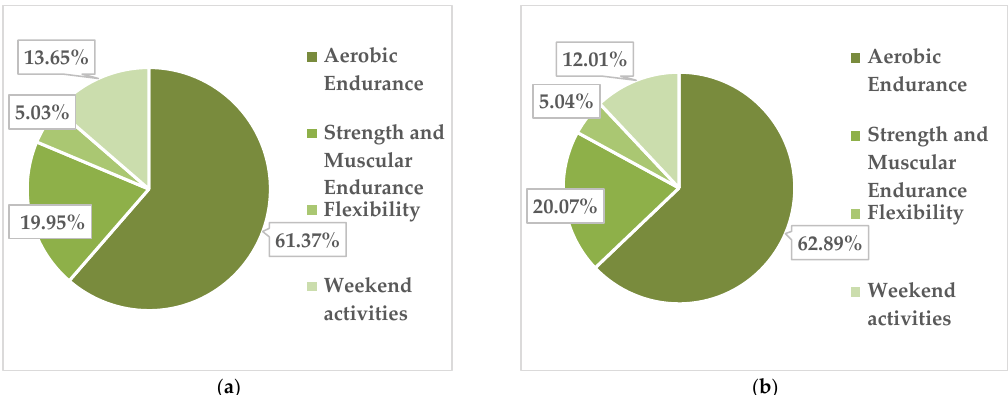
Figure 5. Frequency of preferred activities/module in the physical activity programme in obese girls ( a ), obese boys ( b ).